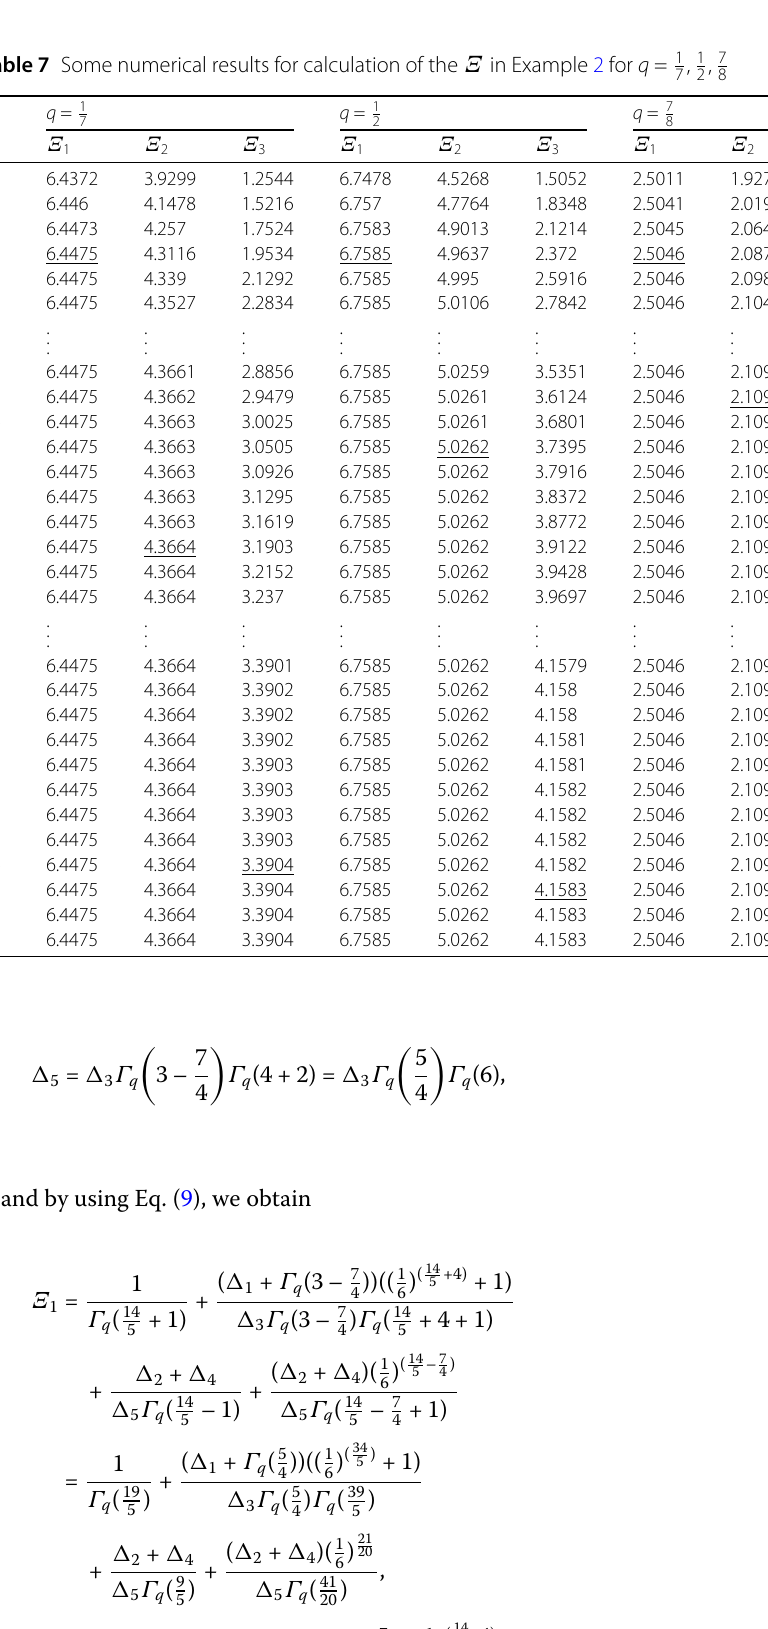
Table 7 Some numerical results for calculation of the Ξ in Example 2 for q = 1